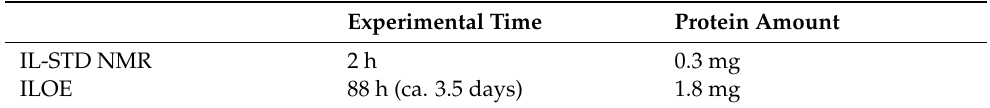
Table 1. Comparison between the experimental time and protein investment needed for the IL-STD vs. ILOE approach for the study of relative orientation of fragments bound to